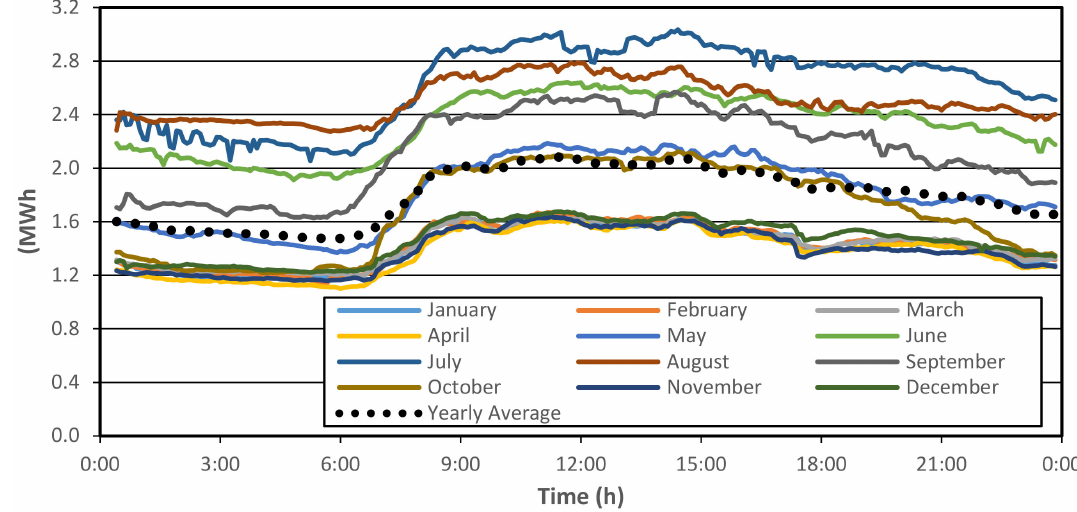
Figure 5. Monthly and yearly average distribution of the electricity consumption of Harran University